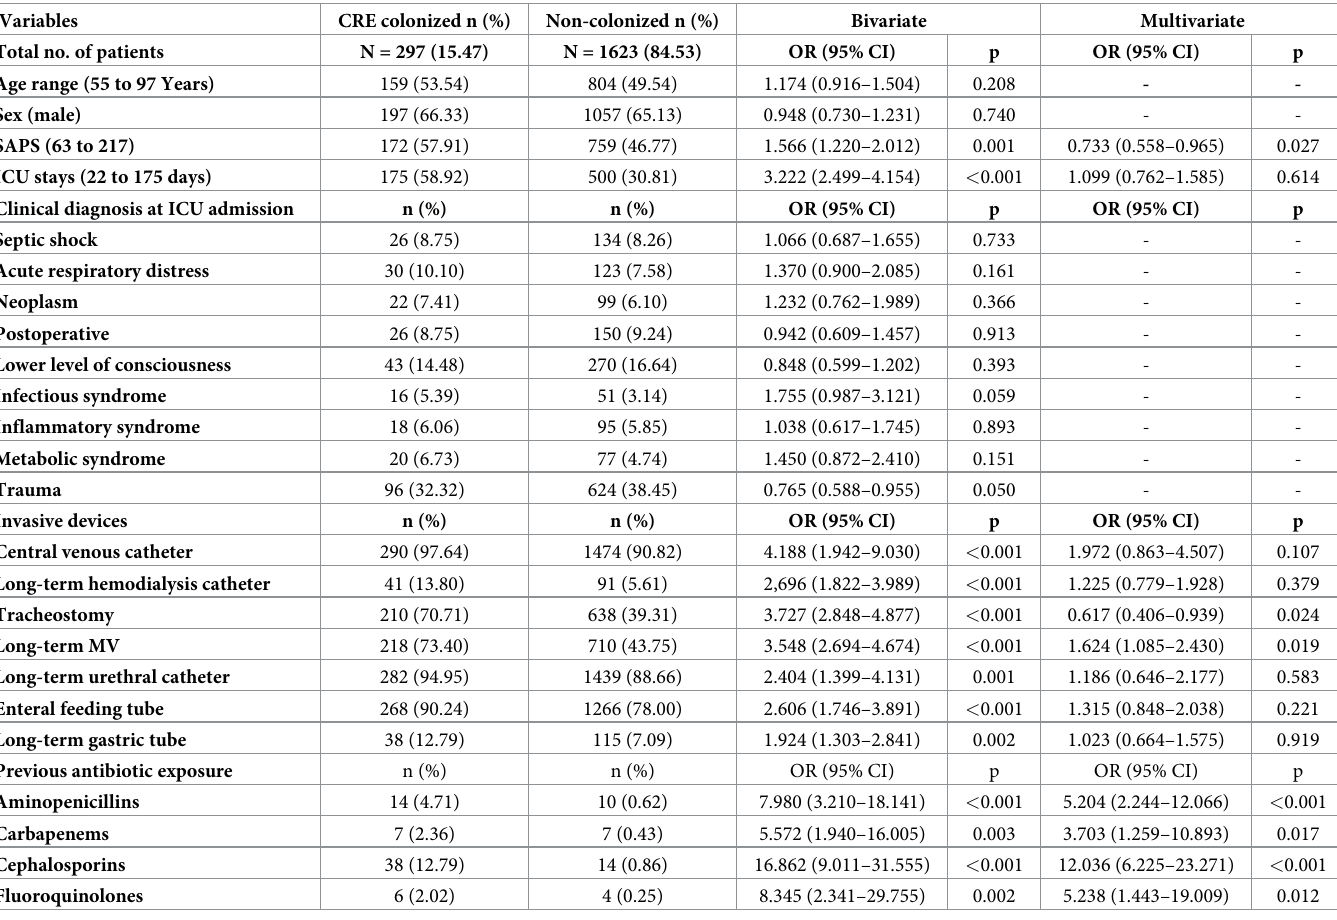
Table 2. Univariate analysis and multivariate logistic regression analysis of risk factors for CRE colonization in colonized versus non-colonized patients. Variables CRE colonized n (%) Total no. of patients